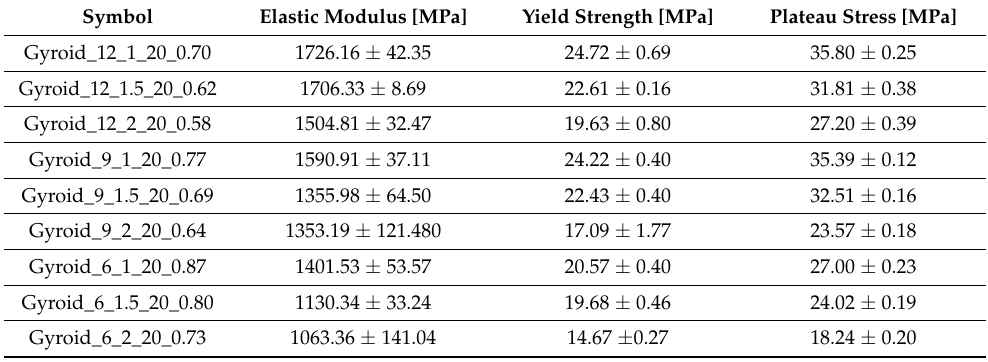
Table 4. Elastic modulus, yield strength, and plateau stress of the tested cylindrical mapped gy- roid